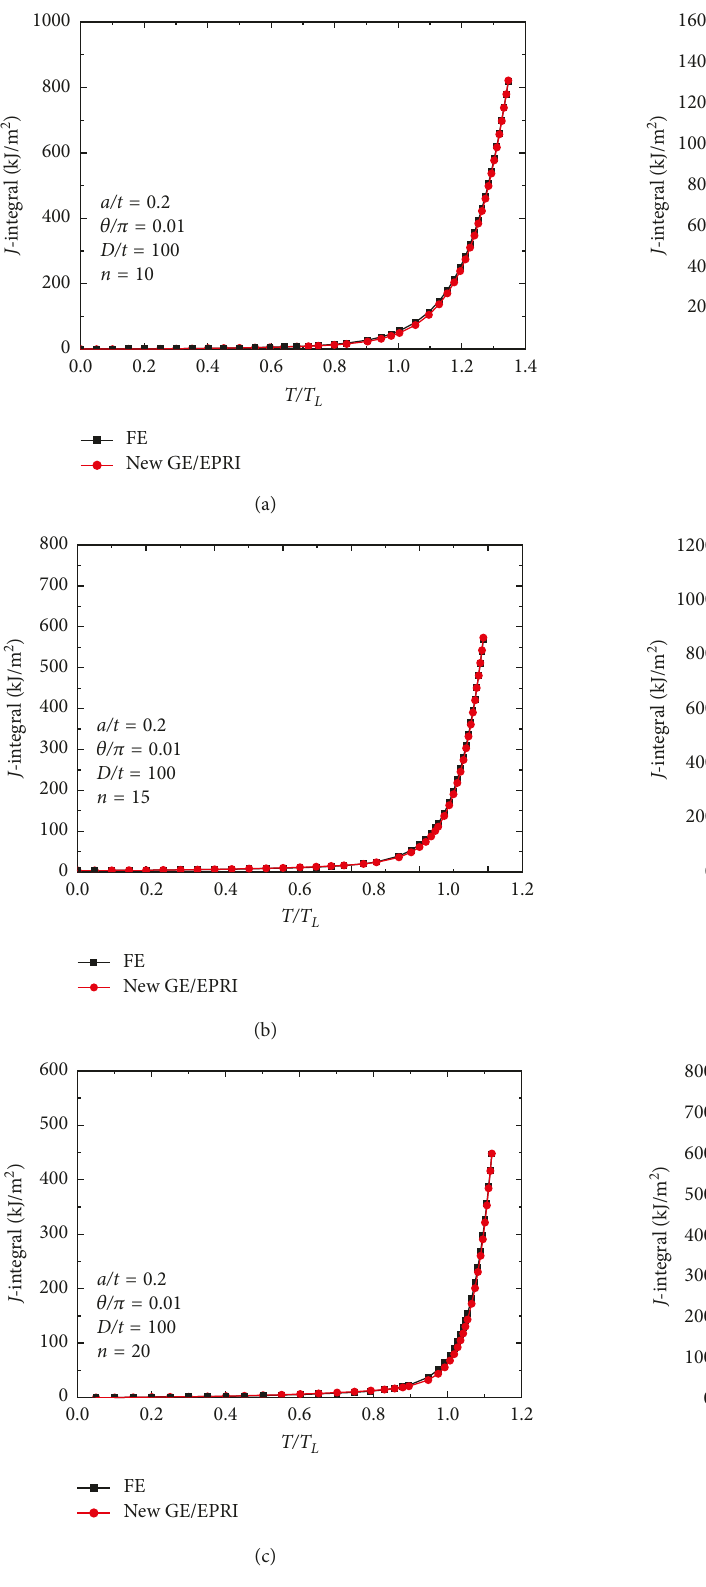
Figure 7: Comparison of J -integral estimated by using new elastic Figure 8: Comparison of J -integral estimated by using new elastic and plastic influence functions with FE results for thin-walled pipes and plastic influence functions with FE results for thin-walled pipes under tension having D / t 100, a / t 0.2, and θ / π 0.01: (a) n 10; under bending having D / t 100, a / t 0.2, and θ / π 0.01: (a) n 10; (cid:31) (cid:31) (cid:31) (cid:31) (cid:31) (cid:31) (cid:31) (cid:31) (b) n 15; (c) n 20. (b) n 15; (c) n (cid:31) (cid:31) (cid:31) (cid:31)